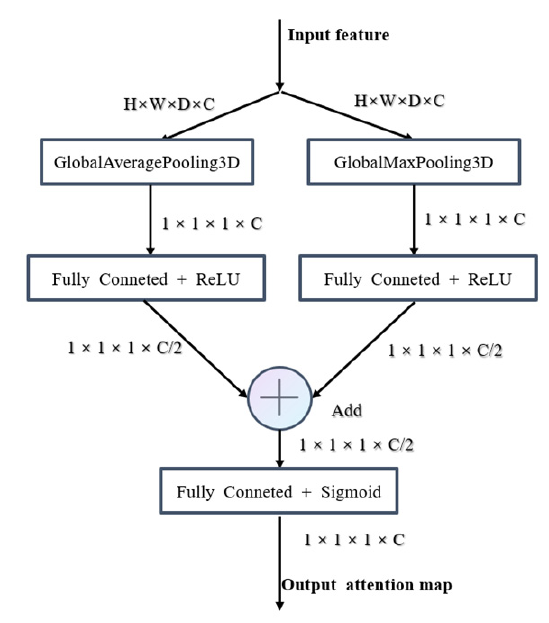
Figure 8. Detailed structure of channel attention module.